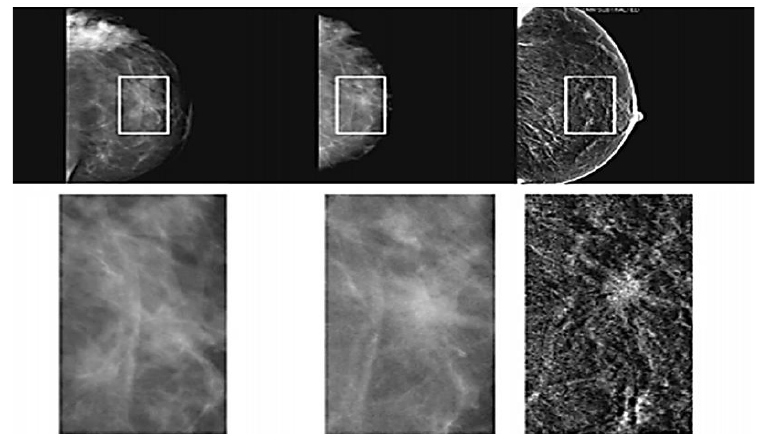
Figure 6. Conventional mammogram of breast cancer [46].